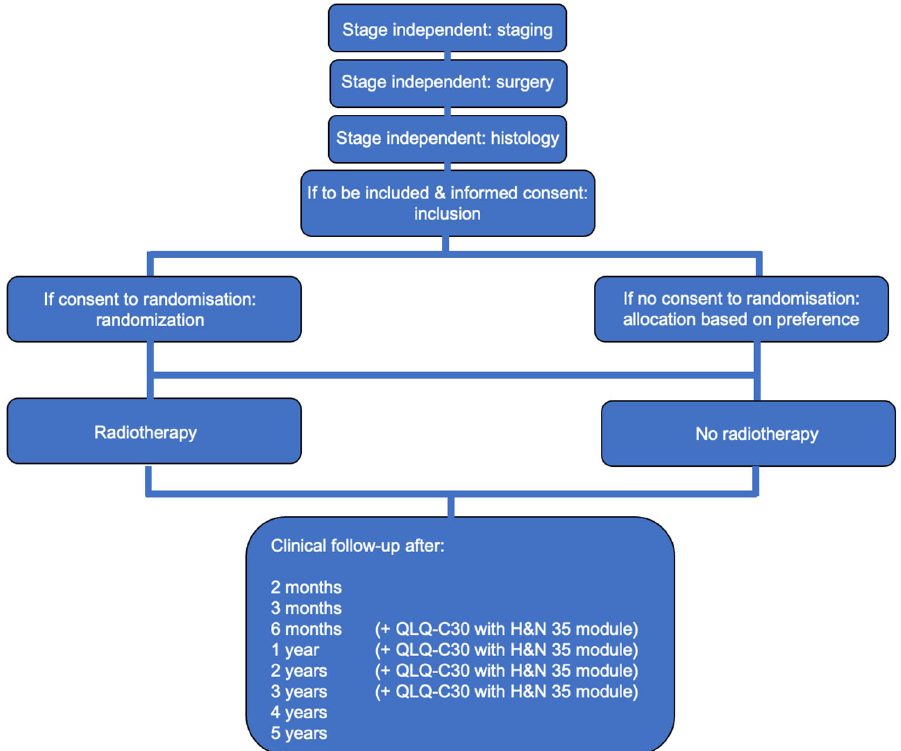
Figure 1. Flow-chart of the study.